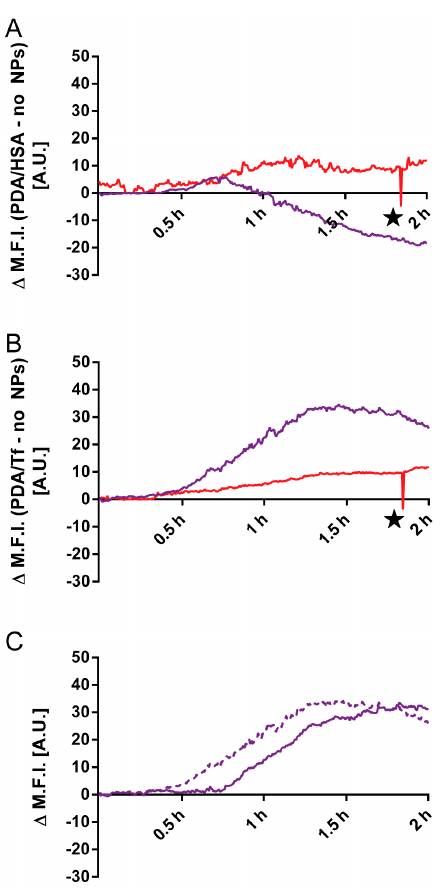
Figure 6. Analysis of the apoptosis rate in the B16F10 mouse melanoma cells, by UV-light irradiation dependent on NP exposure. The rate obtained for the cells not exposed to NPs was subtracted from the rate measured when the cells were exposed to the PDA/HSA NPs, for both regions, independently, yielding the ∆ mean fluorescent intensity (M.F.I.) value ( A ). For the 405 nm results, a negative trend could be observed, whereas, the cell death rate in the 633 nm region increased as expected. Additionally, the effect of PDA/Tf NPs versus the negative control was evaluated by subtracting the negative control from the PDA/Tf NP data ( B ). The apoptosis rate of cells exposed to the PDA/Tf NPs was faster than the negative control, manifesting itself in an increasing ∆ M.F.I. Finally, the ∆ M.F.I. of the 405 nm regions of PDA/Tf vs. the negative control (dotted line) and the PDA/Tf vs the PDA/Tf blocked (solid line) were compared ( C ). There is an observable shift of the effect to a later time-point, indicating a successful blocking of the transferrin receptor. (cid:70) The sudden drop in the 633 nm signal was due to a faulty recording in one of the frames of the repetitions. N =